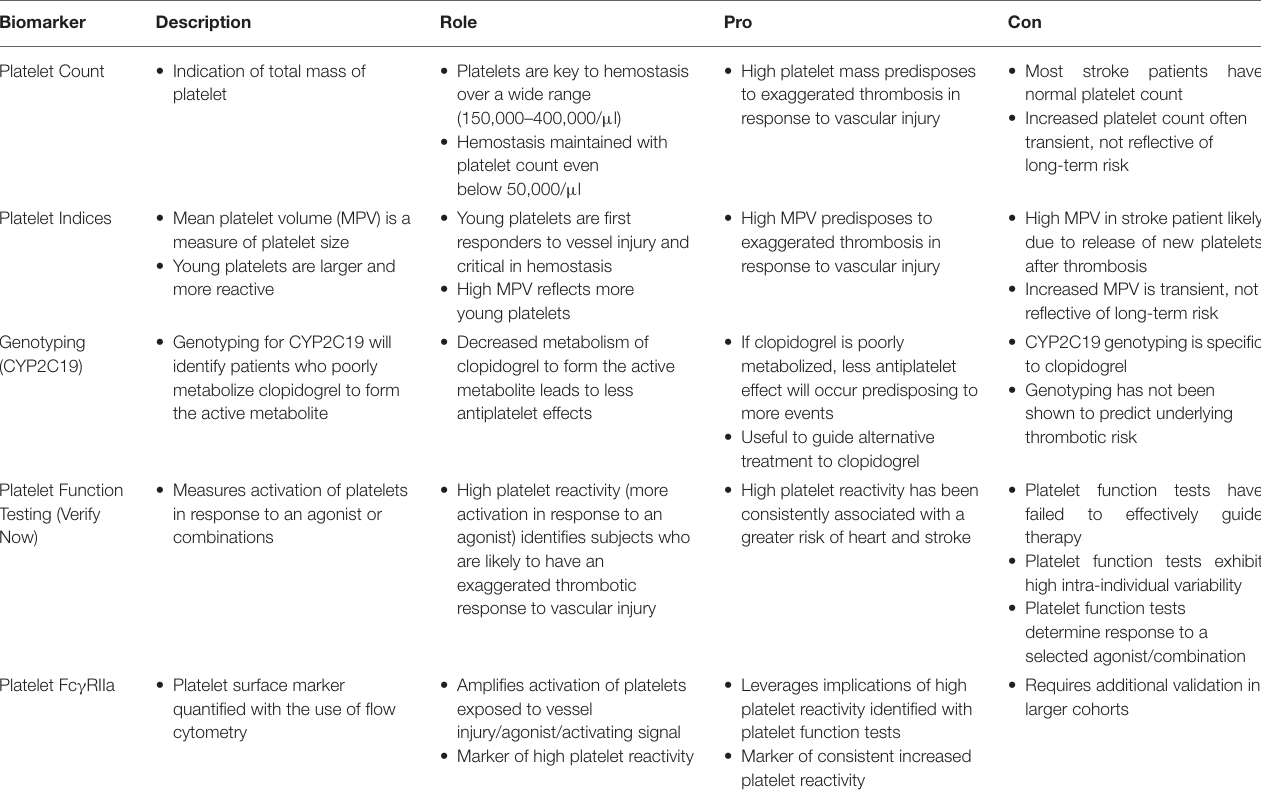
TABLE 1 | Platelet assays and potential use in anti-platelet stroke prevention strategies.